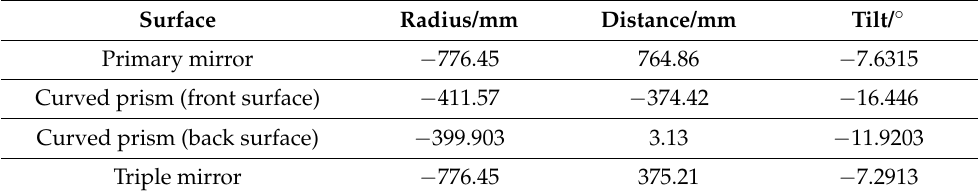
Figure 6. Optical structure of the ultrawide FOV LWIR imaging spectrometer. Table 2. Initial parameters of the LWIR imaging spectrometer.